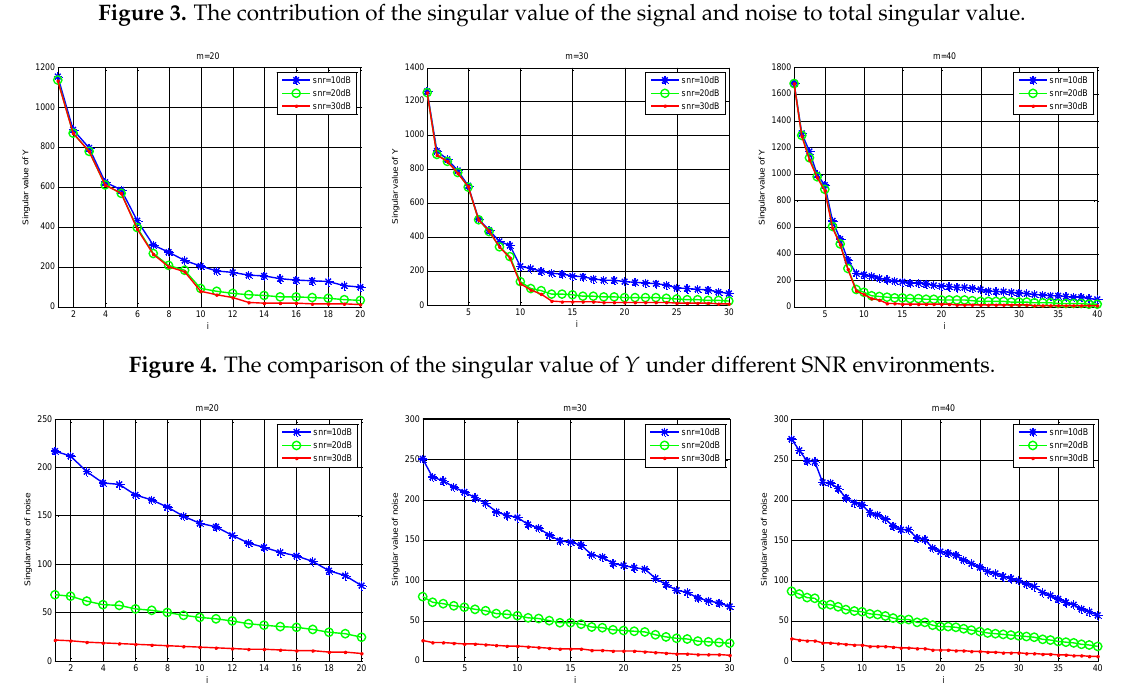
Figure 5. The distribution of the noise singular value.